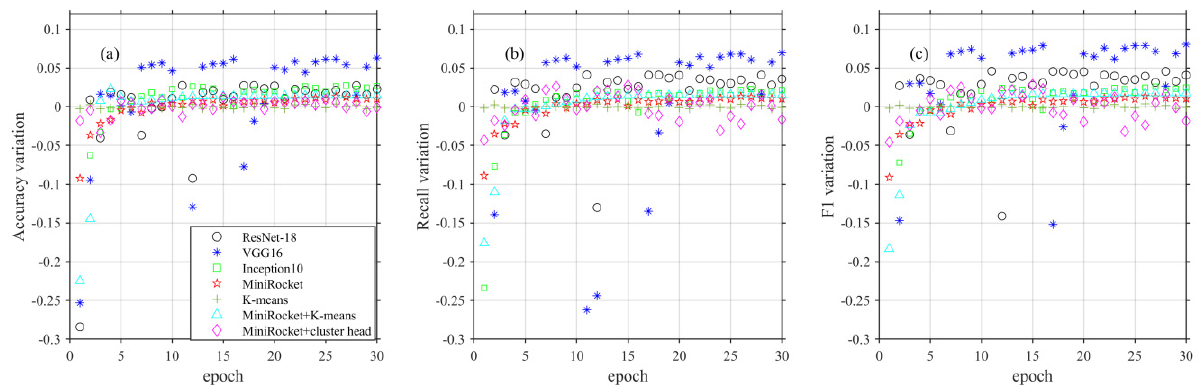
Figure 4. Deviation of each index of each iteration from the median value.( a – c ) represent the accuracy, recall, and F1 values for different models in each epoch. Table 3. Standard deviation of accuracy, recall, and F1 values.